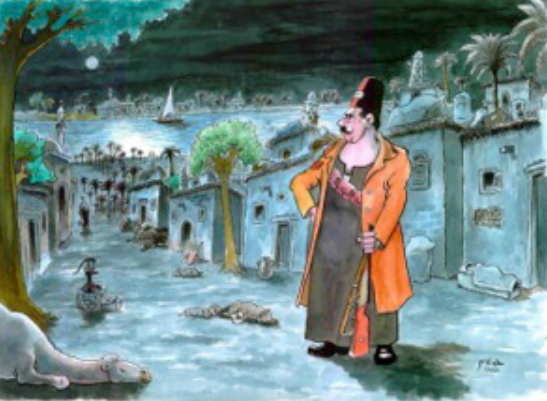
Figure (3) the artist portrayed the Egyptian January 25 th revolution of 2011 by putting in elements that